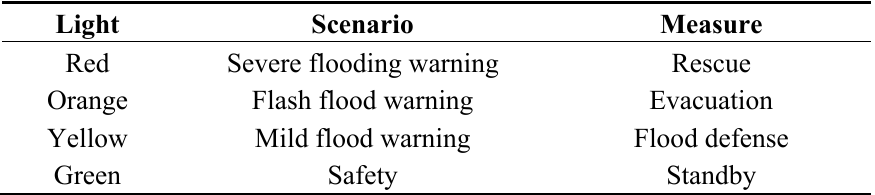
Table 5. Scenarios and measures corresponding to warning